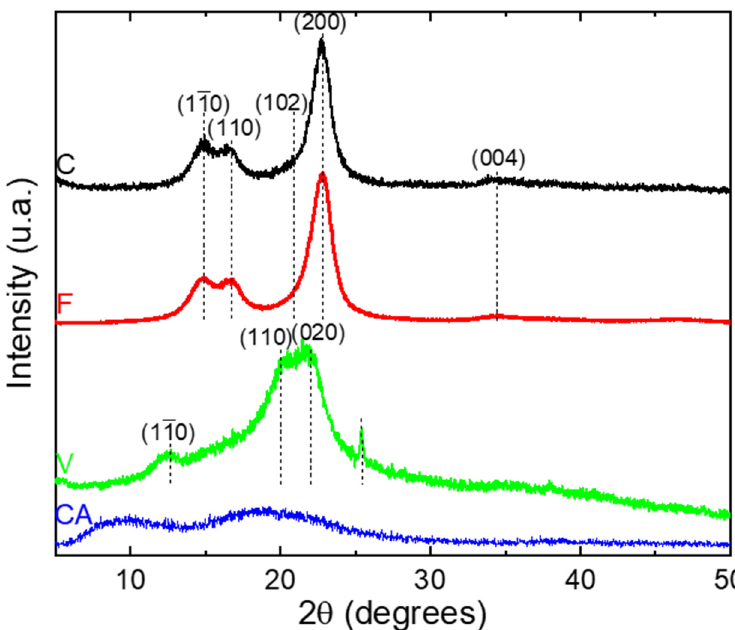
Figure 3. WAXS patterns of C, F, V and CA fibers.